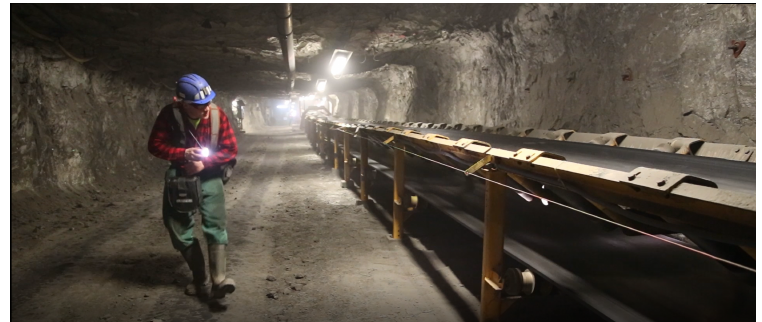
Figure 1. Conveyor belt route inspection in traditional